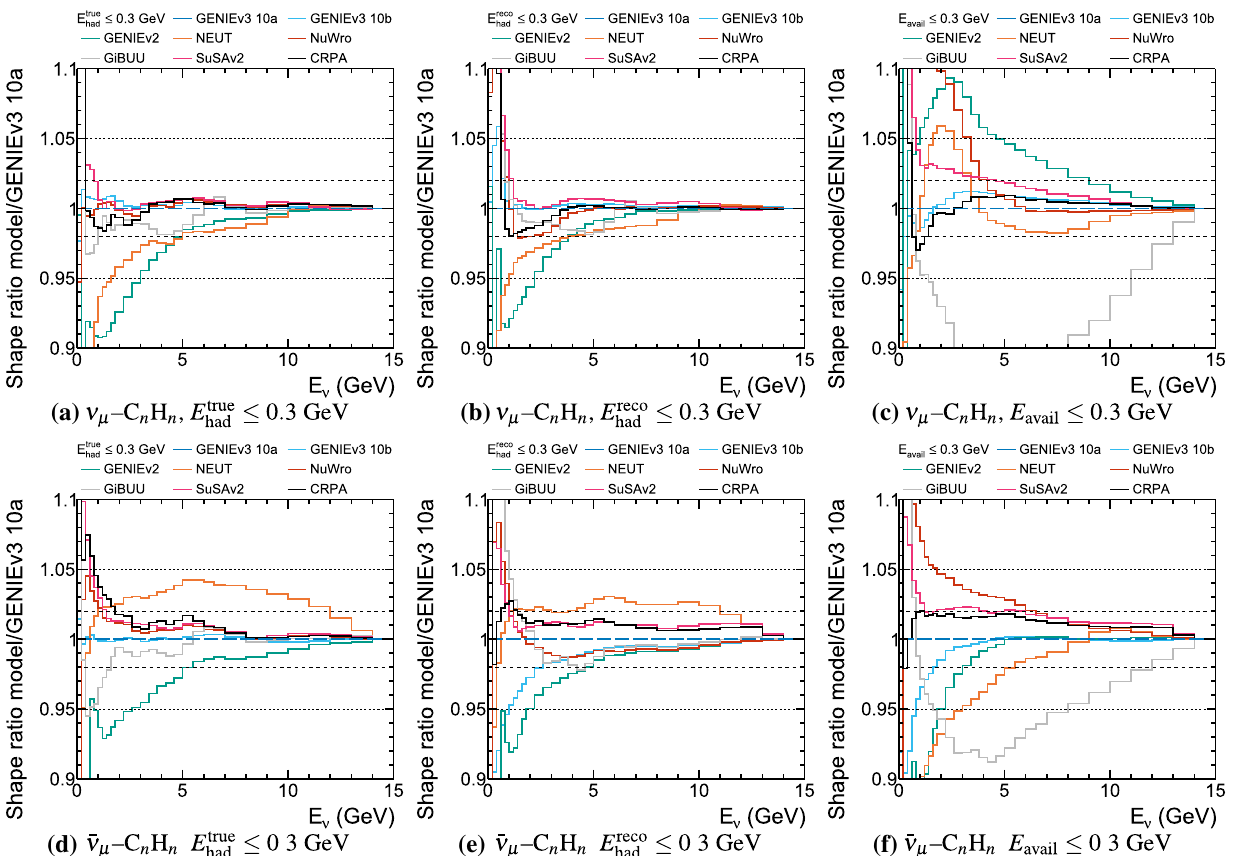
Fig. 14 Comparison of the shape-only ratios (with respect to the GENIEv3 10a prediction) of the ν μ –C n H n and ¯ ν μ –C n H n charged- current cross section with a cut on 0.3 GeV for the three different proxy variables, E true , E reco and E avail , as a function of E true ν . Figures pro- had had